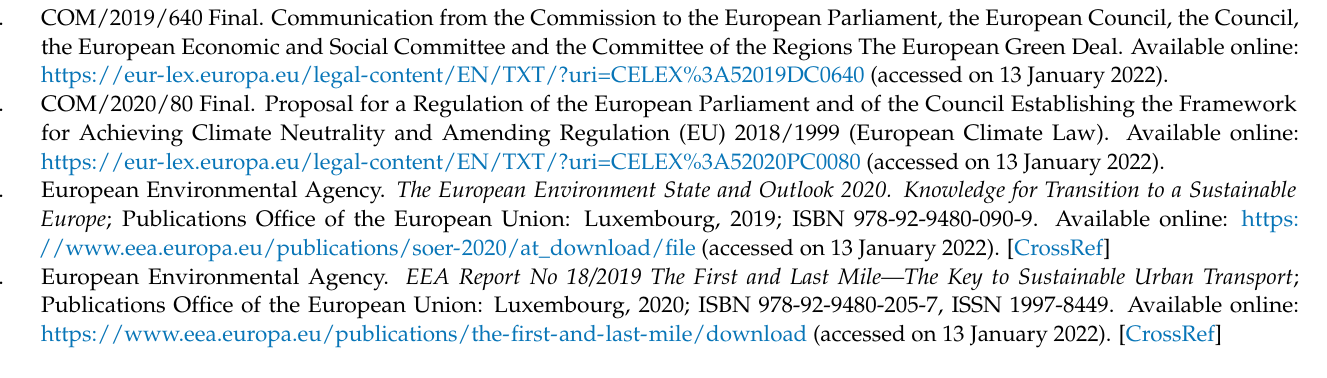
Figure S7: CO and NOx modal emissions on RDE compliant CD100 test during the first cumulative 300 s of internal combustion engine operation, not necessarily consecutive. CD100 indicate charge depleting operation with battery initial State of Charge (SOC) equal to 100. All tests were performed in “hybrid” mode of operation. Table S1: RDE route details for selected examples. Table S2: List of performed experiments. Table S3: Tested vehicles. Table S4: Data